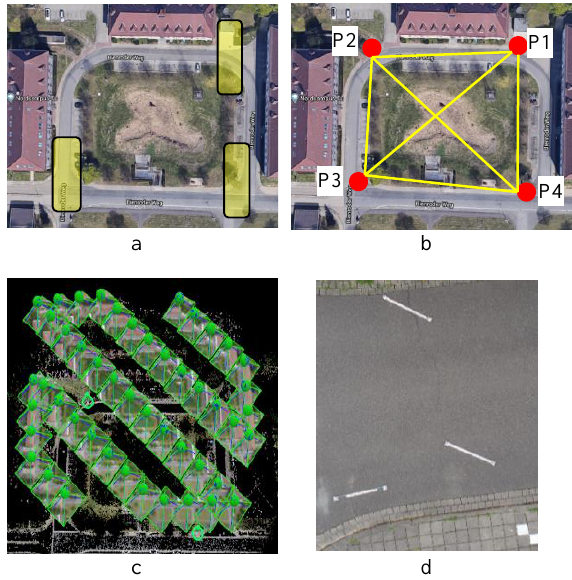
Figure 3 : Configuration of the first experiment; a) Study area captured from 55m height and 3 small areas captured from 10 m height, b) Check distances for quality inspection, c) 55 m images block, d) distributed calibrated scale-bars